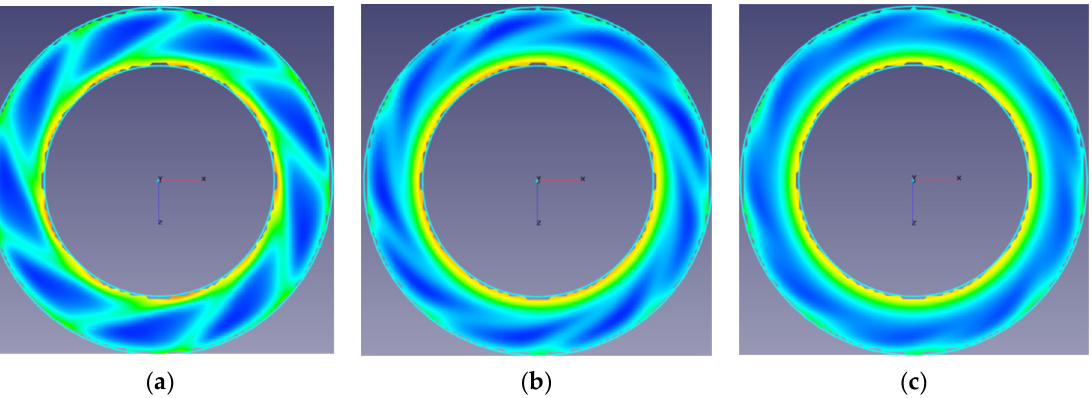
Figure 1. Nature of gas-solids suspension flow jet in the cyclone separation chamber’s inlet area at different distances from the swirler: ( a ) 10 mm; ( b ) 50 mm; ( c ) 100 mm.